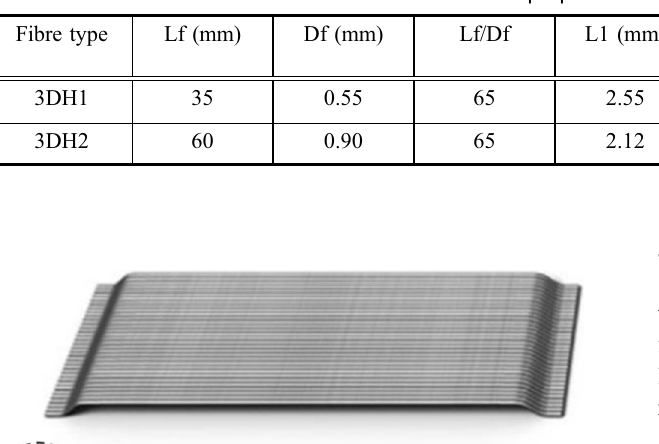
Table 2 General properties of hooked end steel fibres.